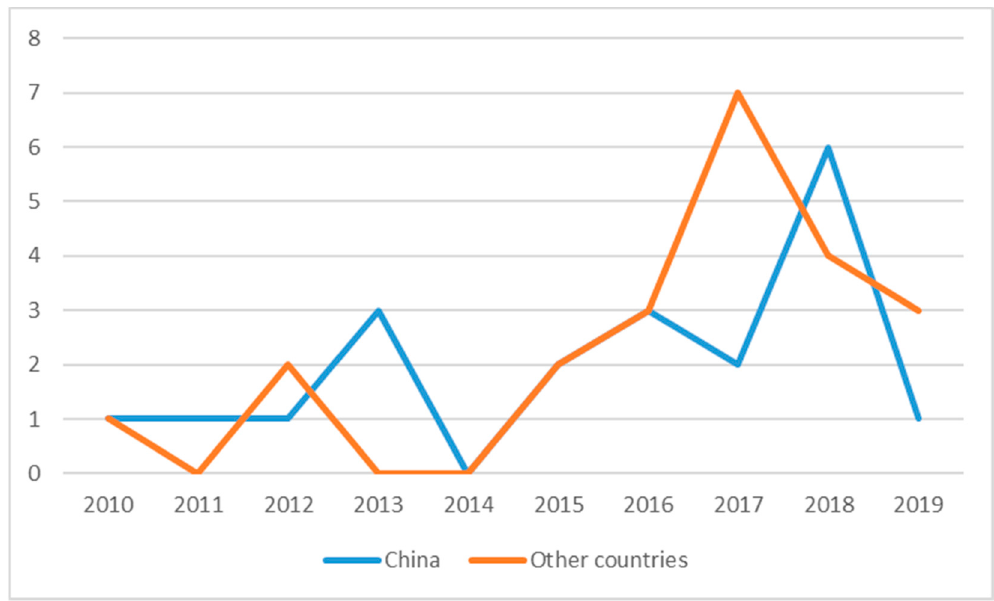
Figure 3. Classification of publication by year.